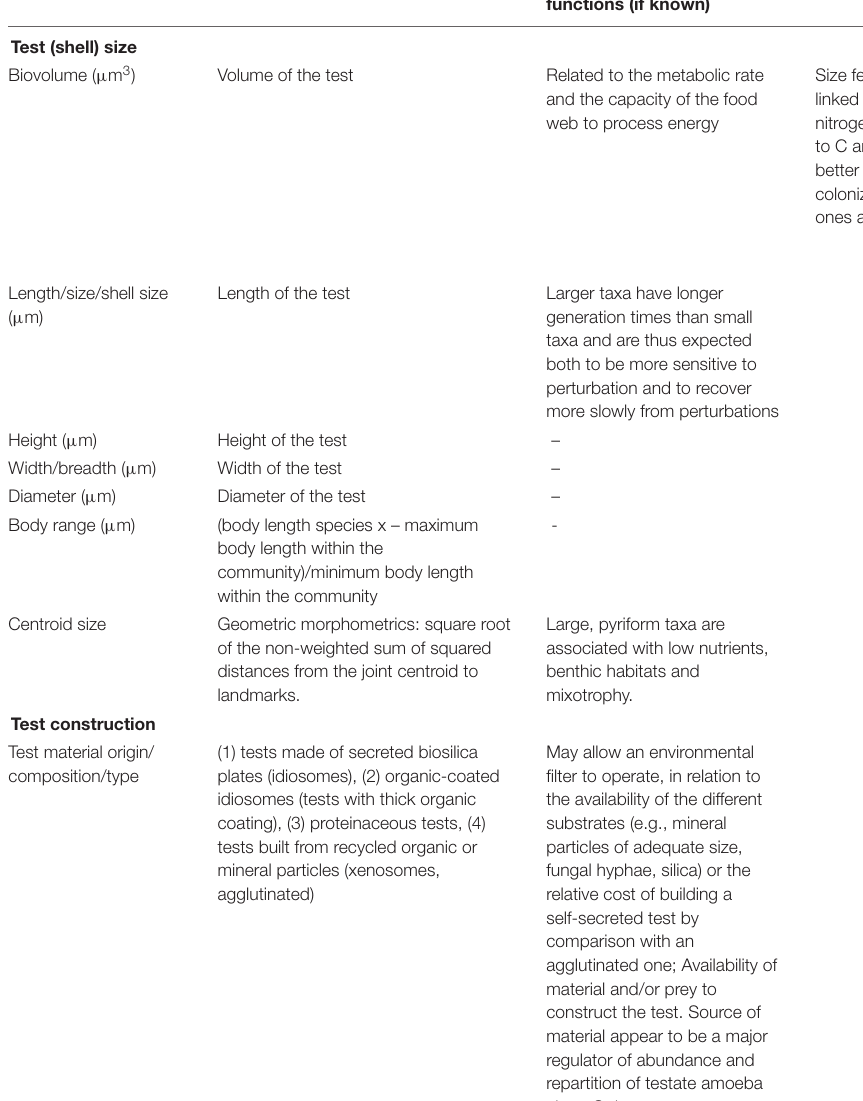
TABLE 1 | List of relevant testate amoeba functional traits explored so far in ecological and palaeoecological studies. Trait (unit; if relevant) Description Trait function, ecological meaning, link to ecosystem functions (if